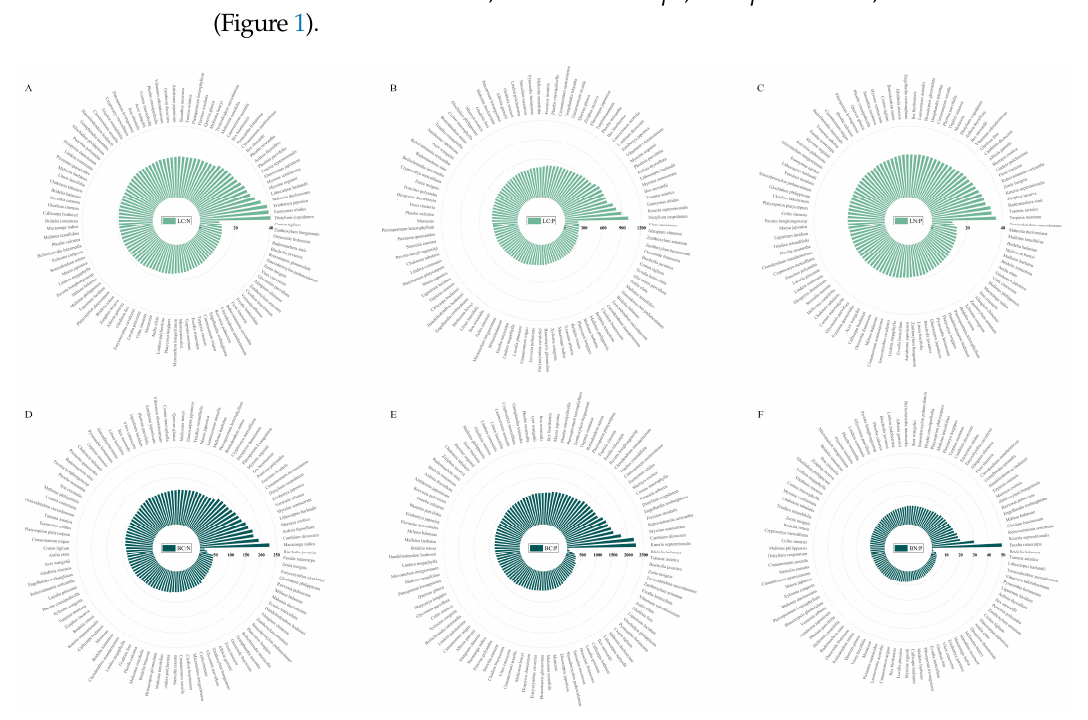
Figure 1. The stoichiometric ratios of C:N ( A , D ), C:P ( B , E ), and N:P ( C , F ) in leaf and branch of different species. The abbreviations are shown in Table 1. The axes represent the values of stoichiometric